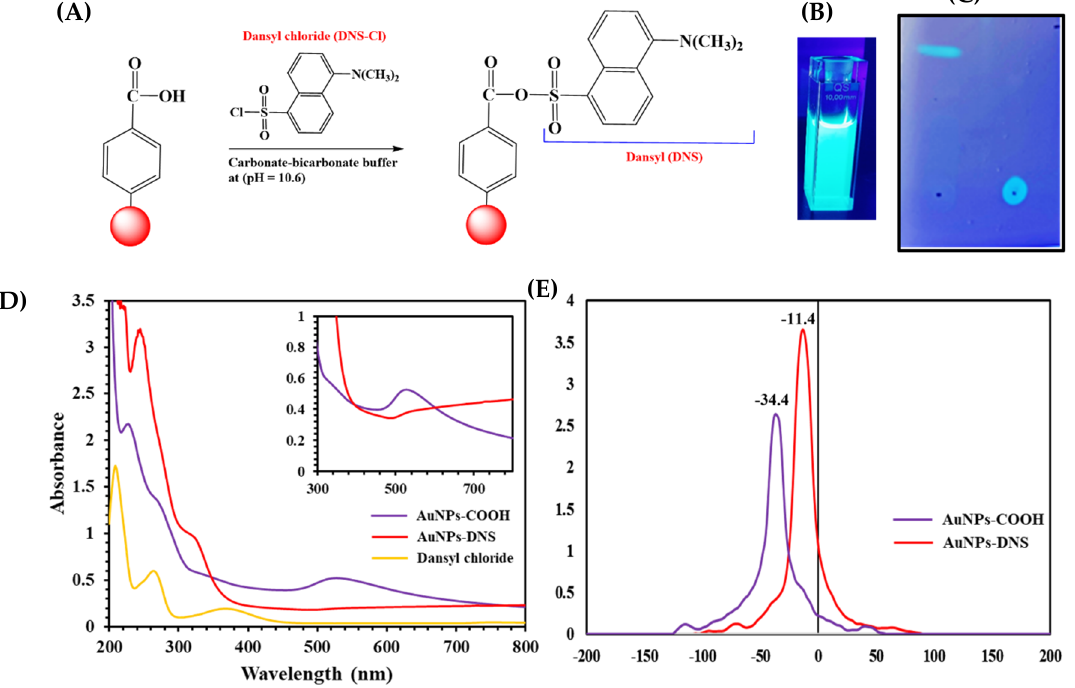
Figure 1. ( A ) Schematic representation showing facile surface derivatization of AuNPs ‐ COOH using DNS ‐ Cl. ( B ) Cuvette of AuNPs ‐ DNS under UV light, ( C , D ) UV ‐ visible spectra showing AuNPs ‐ COOH, DNS ‐ Cl, and AuNPs ‐ DNS. ( E ) Thin ‐ layer chromatography (TLC) for dansyl chloride and AuNPs ‐ DNS UV light irradiation.